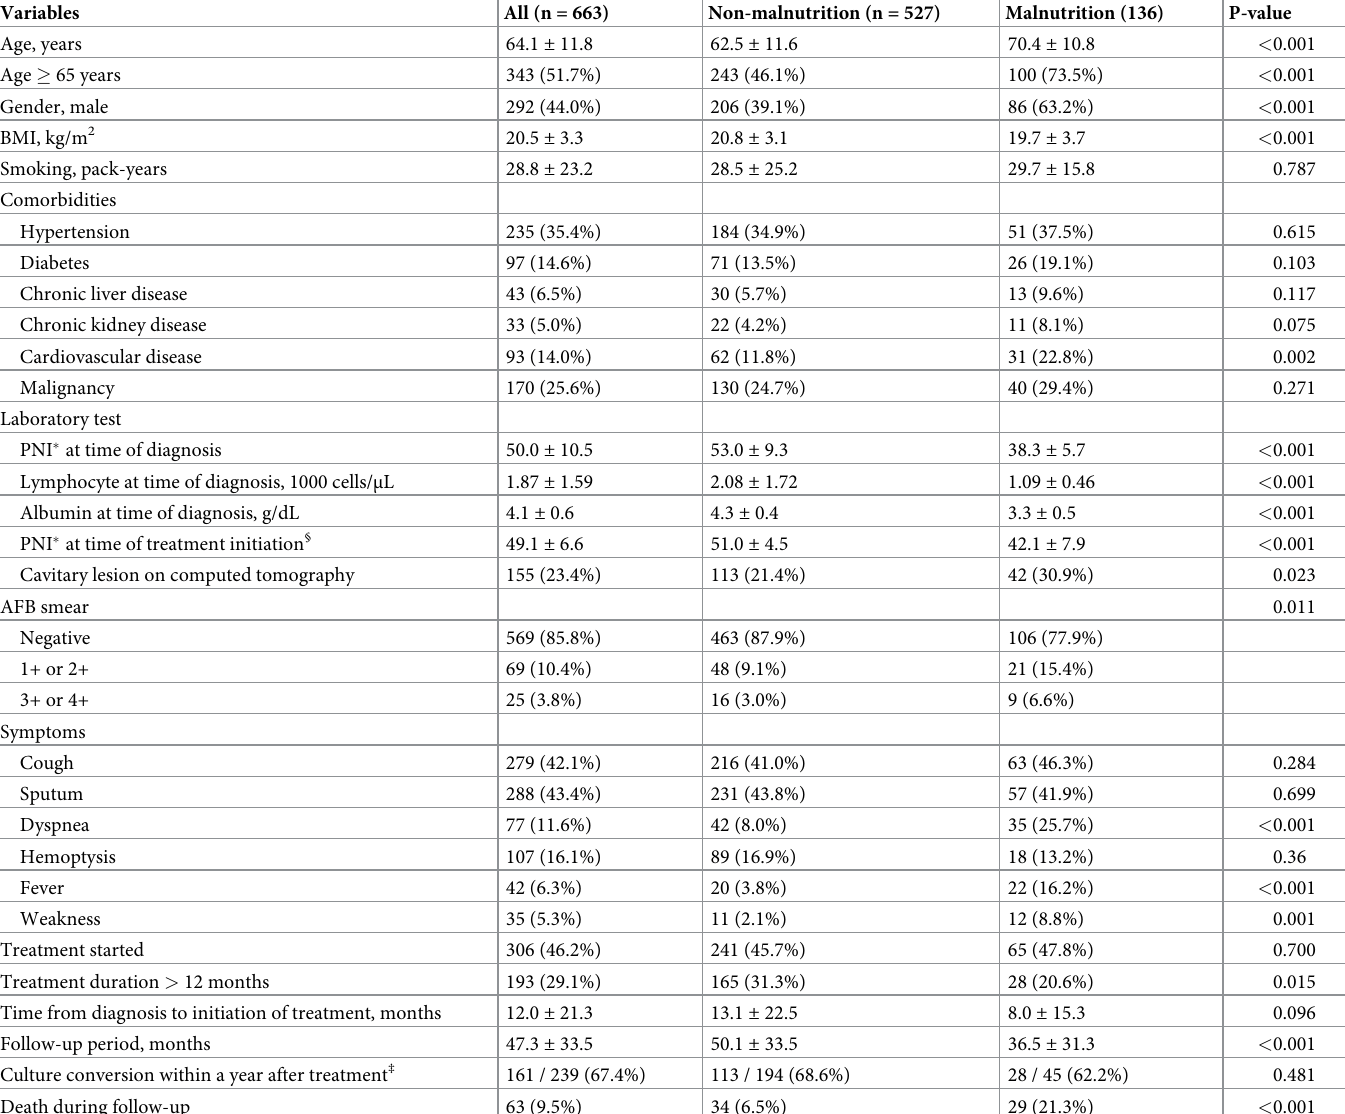
Table 1. Baseline clinical characteristics of 663 patients with Mycobacterium avium complex lung disease with or without malnutrition.